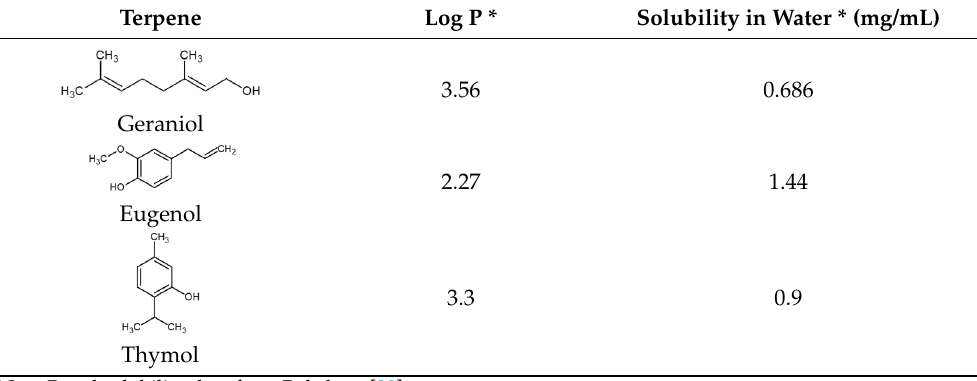
terpenes used for loading in YPs.